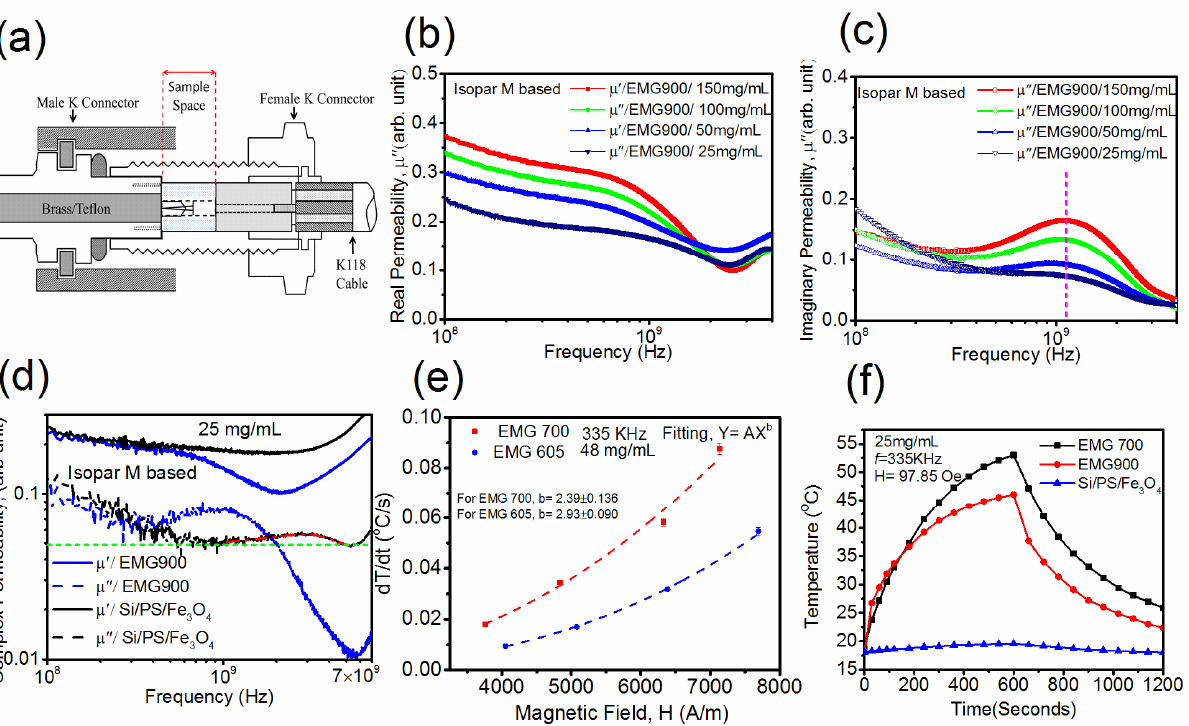
Figure 5. ( a ) K connector (Anritsu) cavity (sample depth= 2.1 mm) for the measurement of the complex dielectric properties of liquid ferrofluid. The short circuit cavity was designed by placing a Brass rod into the inner diameter of male K connector (shown as grey in the image) for open circuit cavity brass rod, and the pin of the male connector was replaced by a similar diameter Teflon rod and pin( b , c ). Real ( b ) and imaginary ( c ) part of the permeability of the Isopar-M-based EMG 900 samples at different concentrations. ( d ) Complex permeability of Isopar-M-based Si/PS/Fe 3 O 4 and EMG 900 samples. ( e ) Initial heating rate vs. magnetic field curve, measured at a frequency of 335 KHz at a sample concentration of 48 mg/mL for water-based EMG 700 and EMG 605 samples, and ( f ) time dependent temperature curve (heating first 10 min, cooling next 10 min) of water-based EMG 700 and Si/PS/Fe 3 O 4 and Isopar-M-based EMG 900 samples.